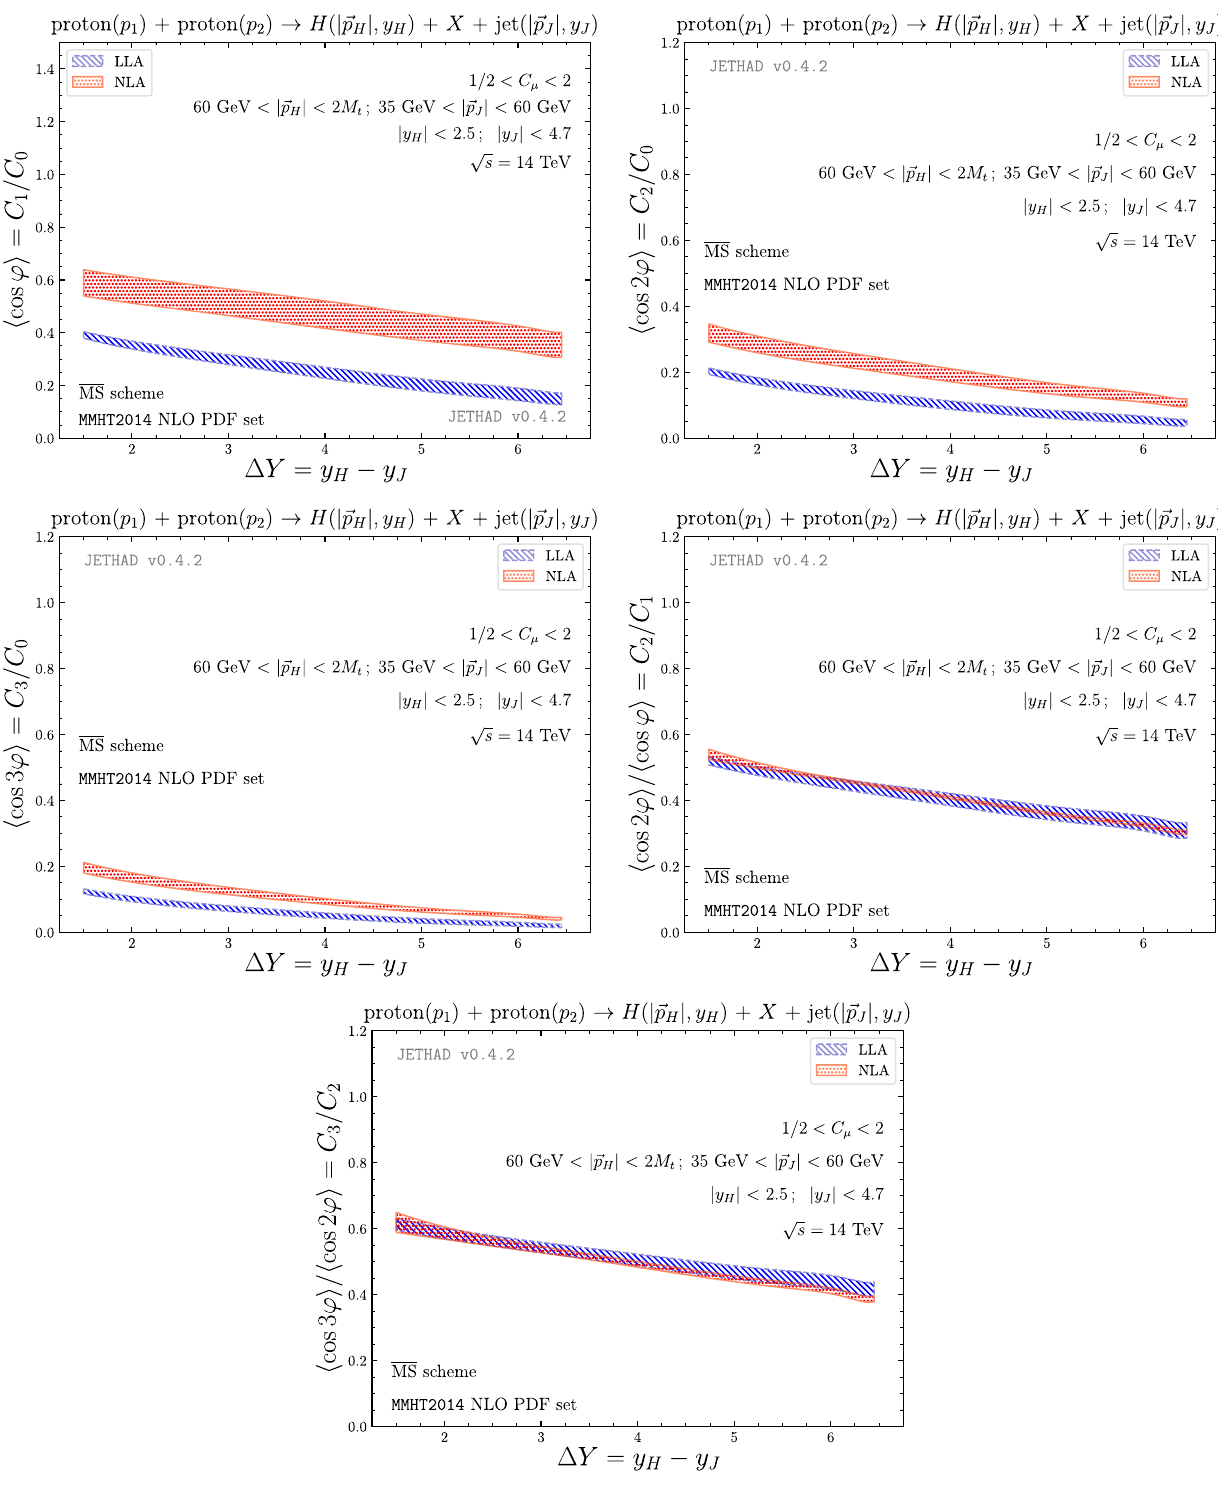
Fig. 7 (cid:6) Y -dependence of several ratios R nm ≡ C n / C m , for the inclusive Higgs-jet hadroproduction in the disjoint p T -windows configuration √ s = 14 TeV. Shaded bands give the combined effect of the scale variation with the uncertainty coming from the phase-space numerical and for